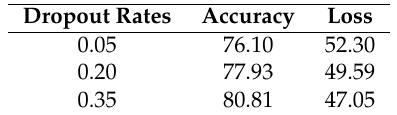
Table 5. Hyper-parameter tuning of 12.5-s samples by Applying different Dropout